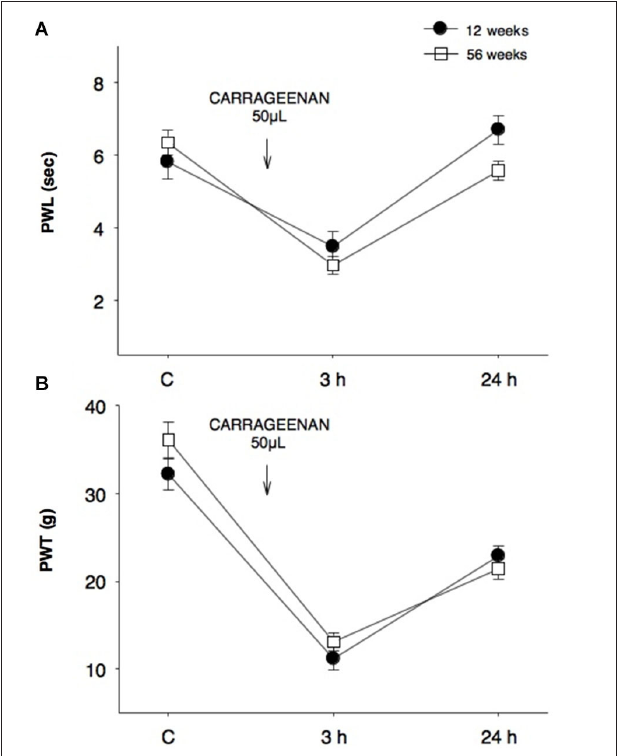
FIGURE 1 | Comparison of thermal and mechanociceptive responses between young and old rats. (A) Paw withdrawal latency (PWL, s) and (B) paw withdrawal threshold (PWT, g) values in 12-week old young rats (black dots) and 56-week old rats (white squares) in control (C), 3 and 24 h after CAR intraplantar injection for the first time. No significant differences were found between groups. Data are expressed as mean ±